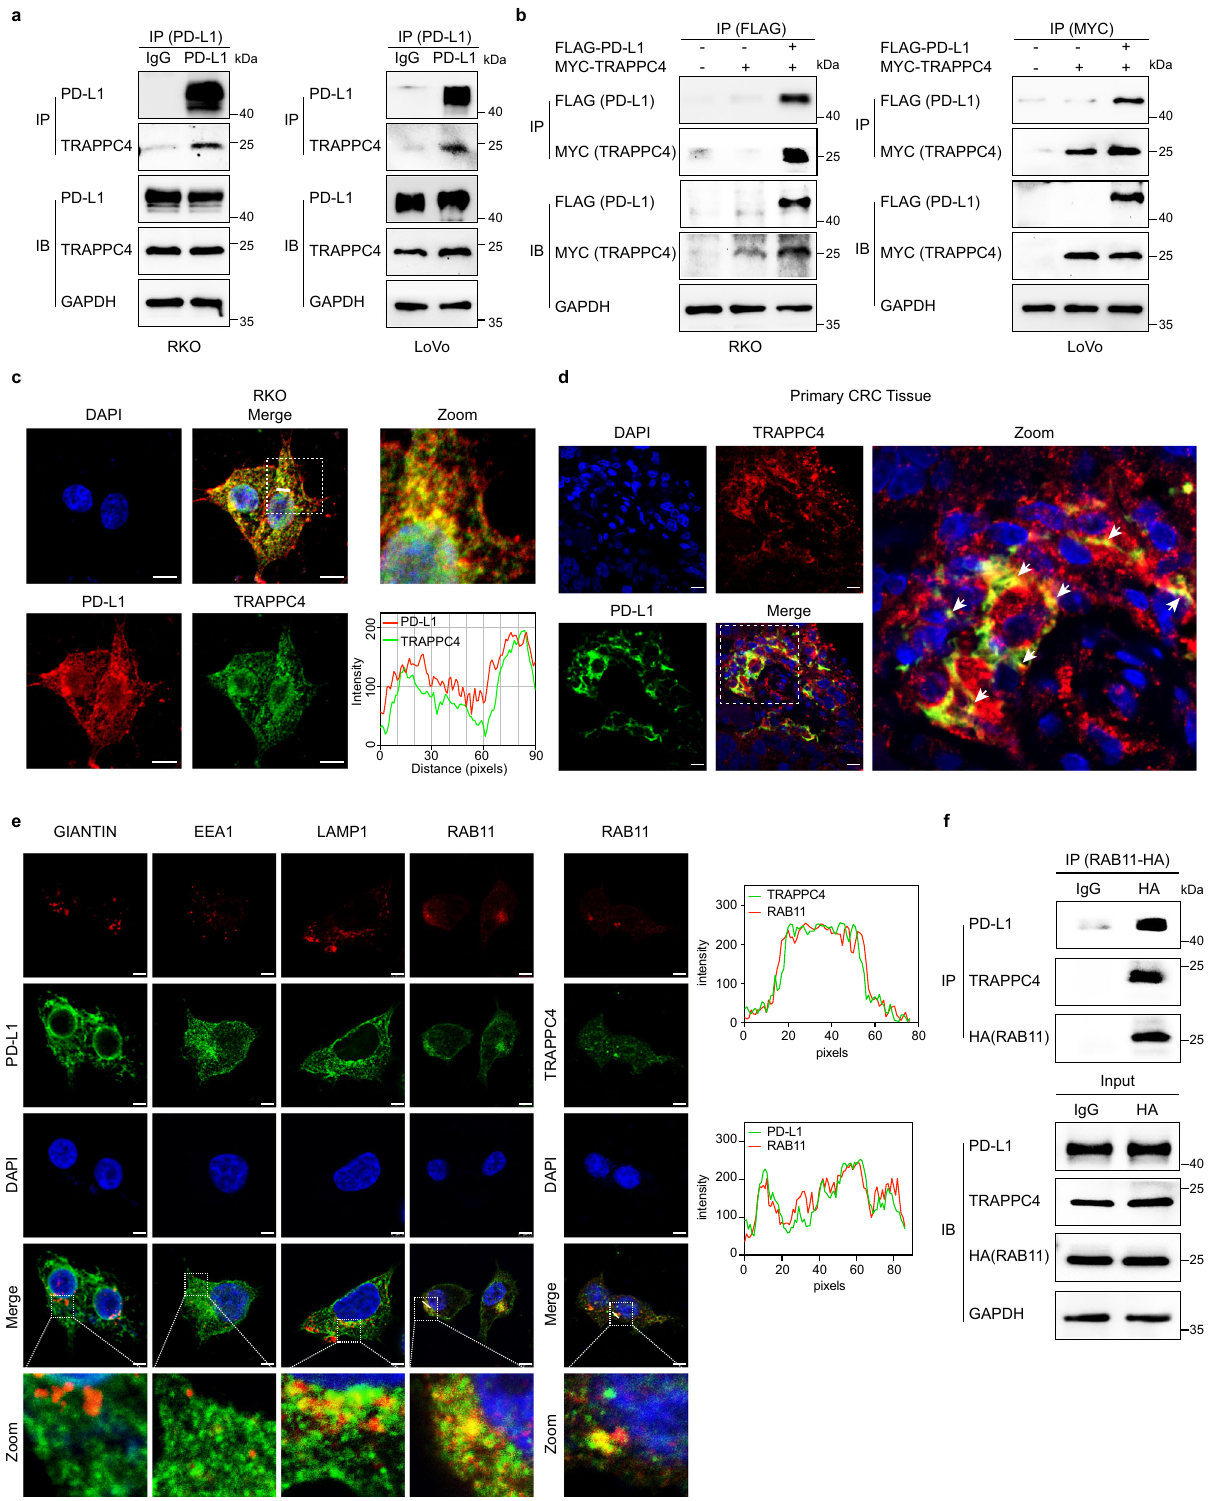
antitumor immunity in response to anti-PD-L1 therapy, includ- ing pronounced CD8 + T-cell in fi ltration, and increased propor- tions of CD69 + CD8 + T cells and CD107a + CD8 + T cells (Fig. 6e – g and Supplementary Fig. 8a – c). The proportion of IFN- γ -producing CD8 + T cells also increased in anti-PD-L1 treated Trappc4-OE tumors (Fig. 6h). These results indicated